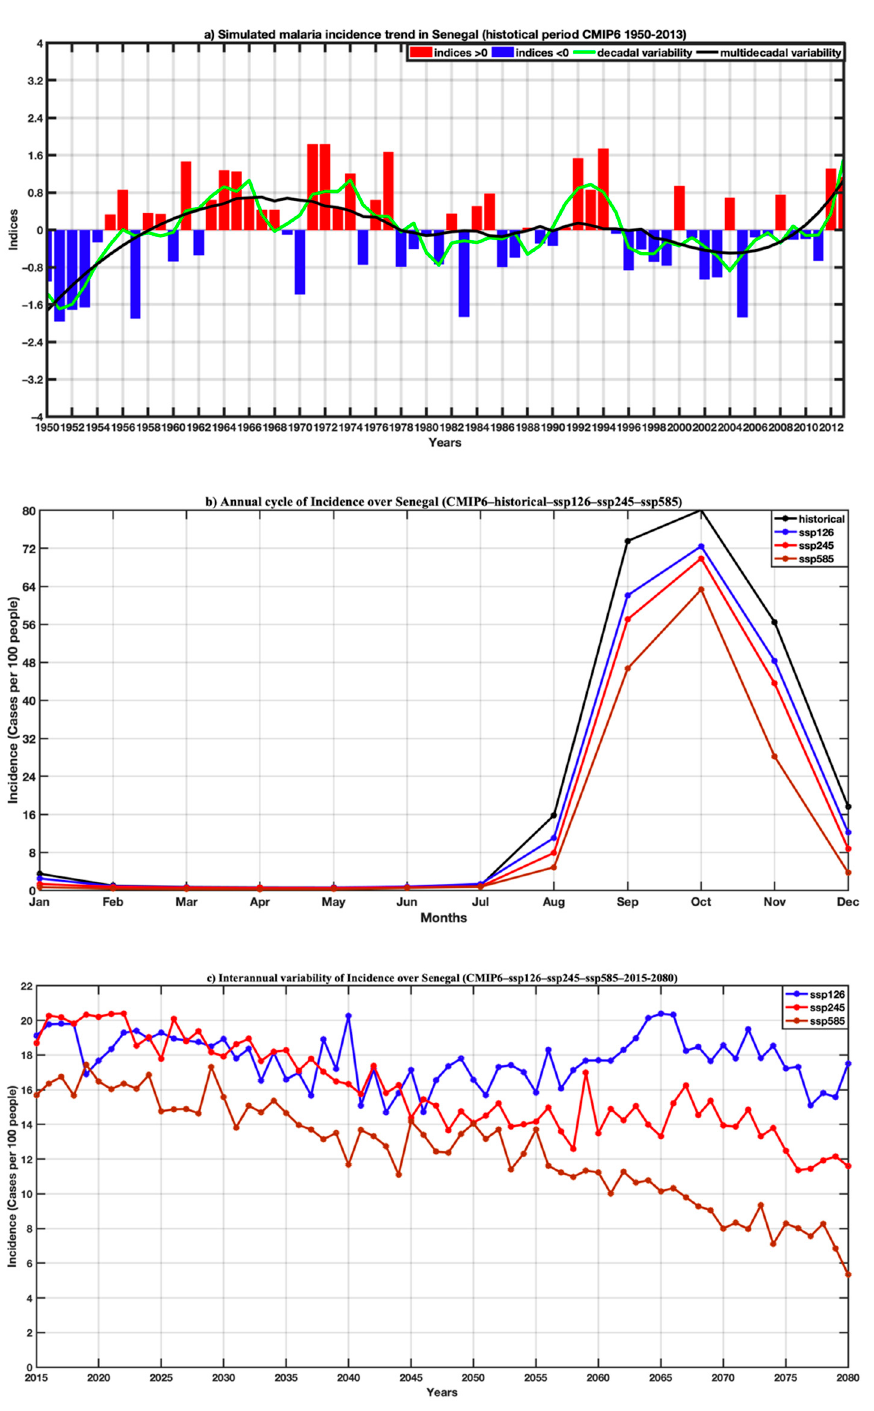
Figure 14. ( a ) Trend in malaria incidence averaged over Senegal for the historical period 1950–2013 (simulation of the LMM model based on precipitation and temperature of the overall average of the CMIP6 models) highlighting the interannual variability, the variability decennial and multi-decadal; ( b , c ) respectively, annual cycle of malaria incidence in Senegal with historical data (1950–2013), and projections (2015–2080) for scenarios SSP126, SSP245, SSP585 of